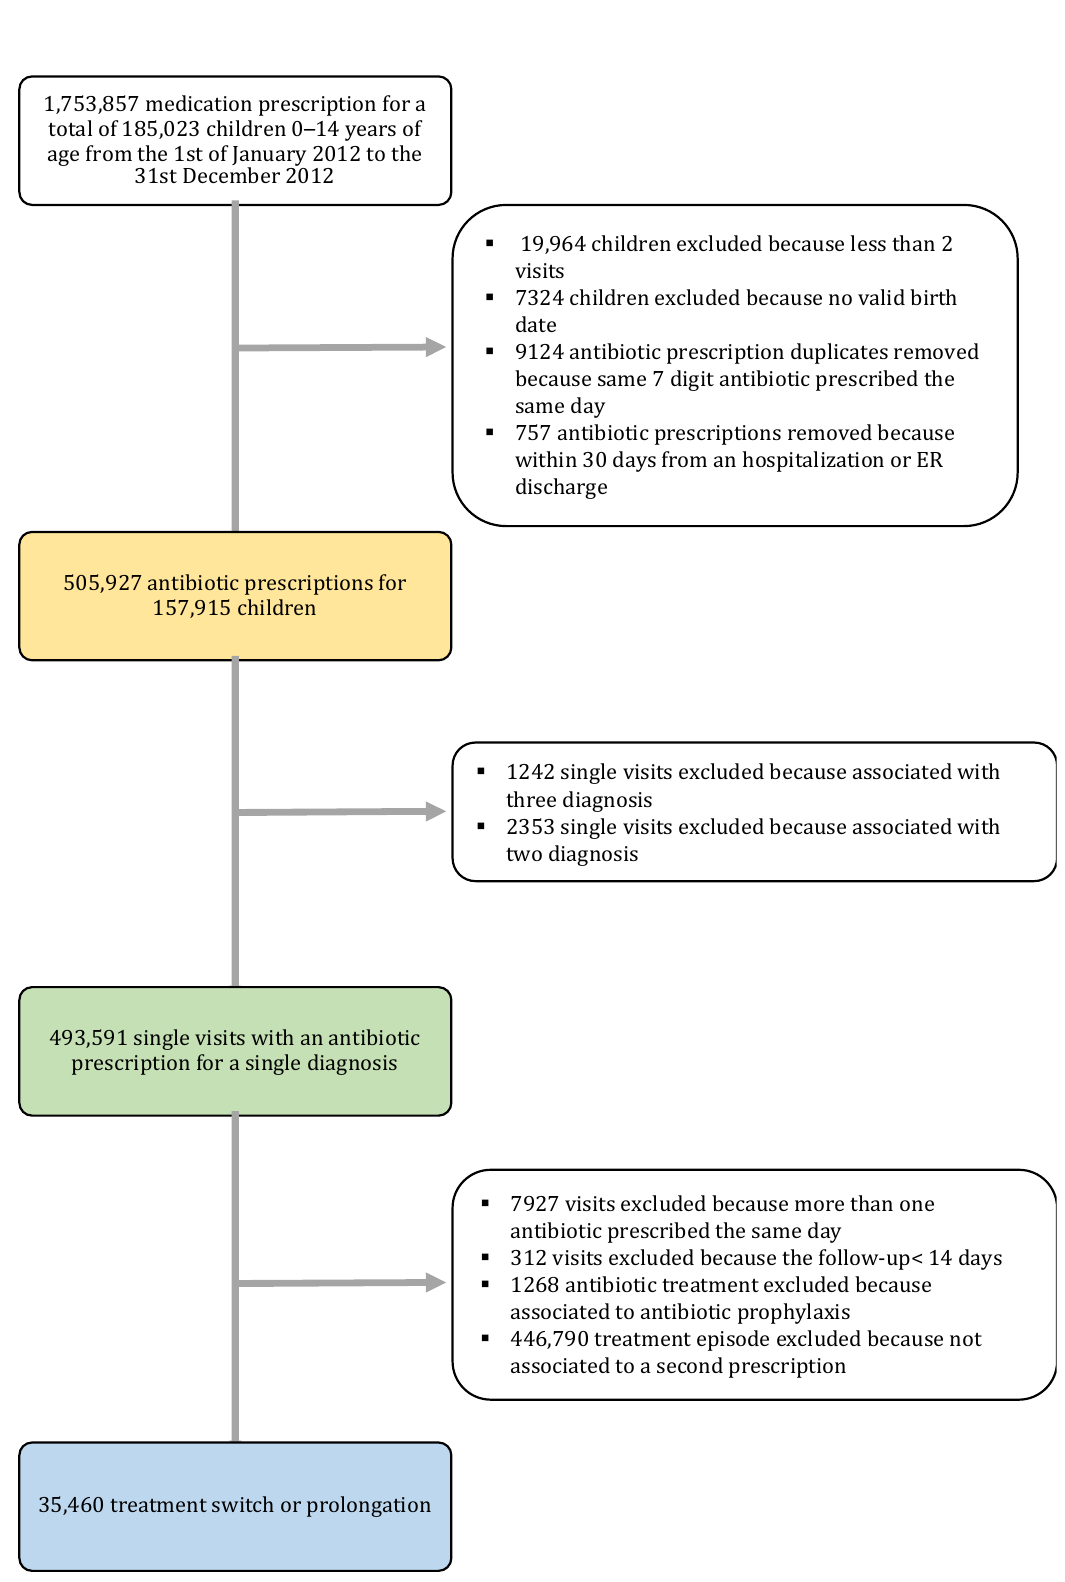
Figure 1. Flow chart of the data included and excluded from the different analyses. The yellow box represents the overall data used for the antibiotic index and prescription rate analysis stratified by age class and calendar year. The green box represents the overall data used for the prescription rate analysis stratified by age class, calendar year, and a single diagnosis. The light blue box represents the overall treatment episodes considered for the evaluation of treatment switching and